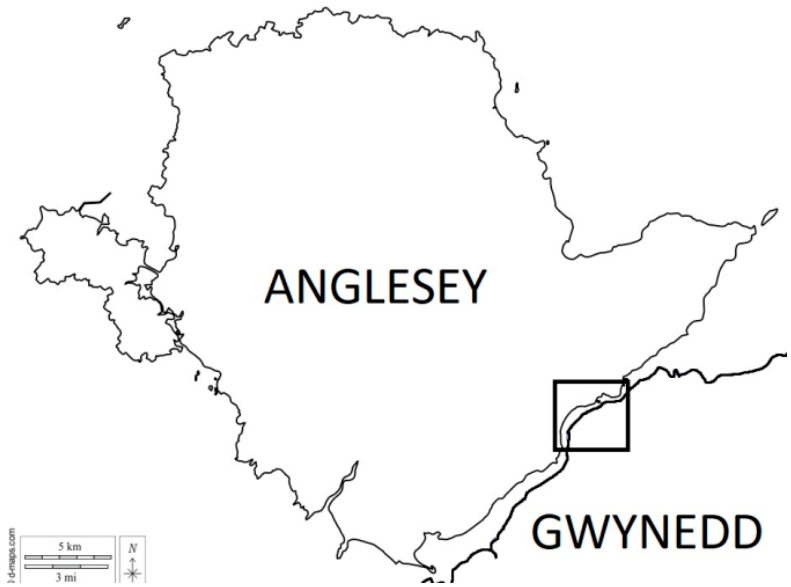
Figure 1. The island of Anglesey and north Wales coast separated by the Menai Strait sea channel. The mainland study area is demarked by a black